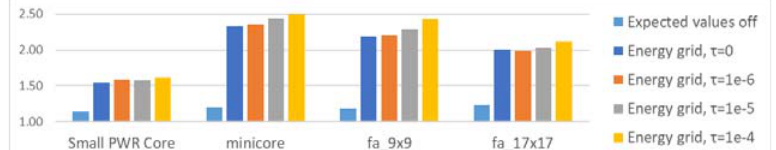
Figure 2. Speedup of criticality